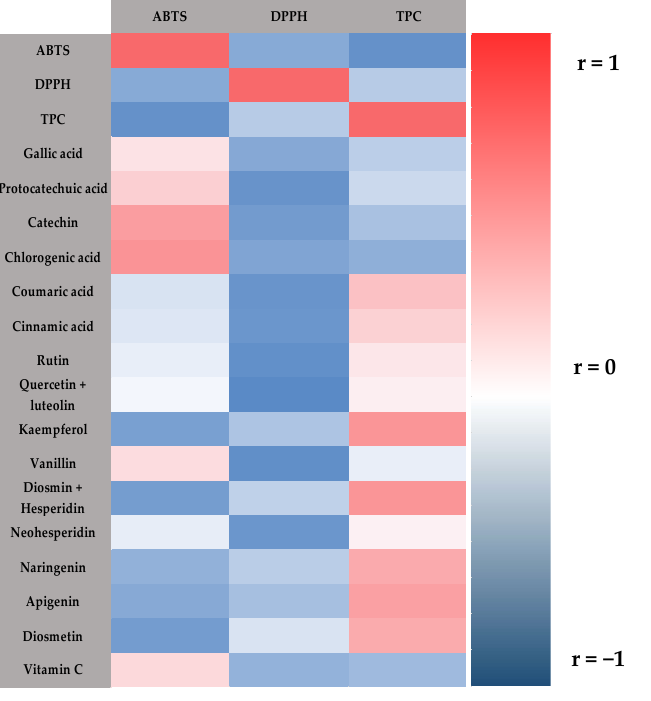
Figure 2. Heat map of the Pearson’s correlation of total polyphenol content, individual phenolic compounds and vitamin C with antioxidant capacity; TPC: Total polyphenol content. Total polyphenol content (r = −0 .72) presents a negative correlation with antioxidant capacity by ABTS methodology, while it does not present a correlation (r = −0 .17) with DPPH methodology, but a similar trend is observed. Diosmin + hesperidin (r = 0.8) and apigenin (r = 0.74) present a positive correlation with TCP.